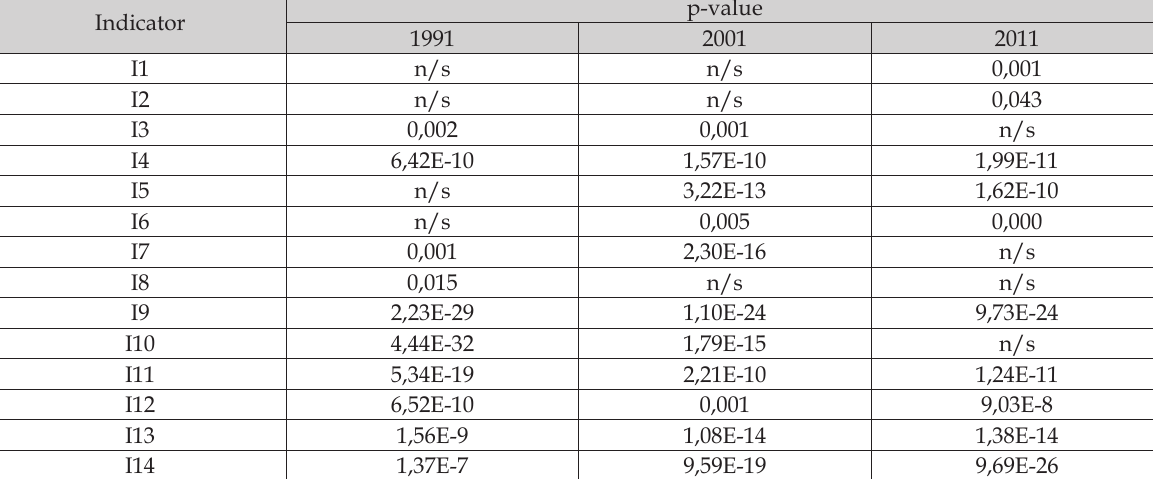
Table 1. Results of ANOVA